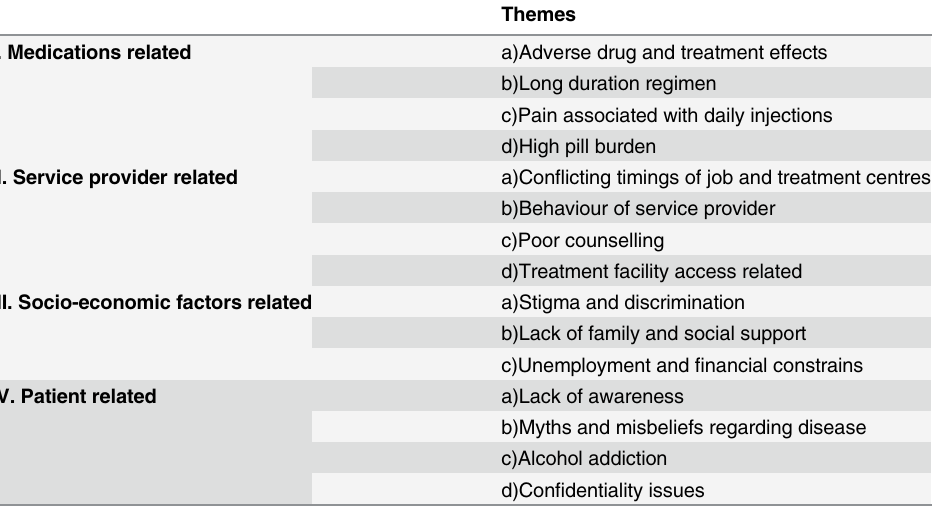
Table 1. Common themes that emerged during in-depth interviews with LTFU MDR-TB patients and treatment